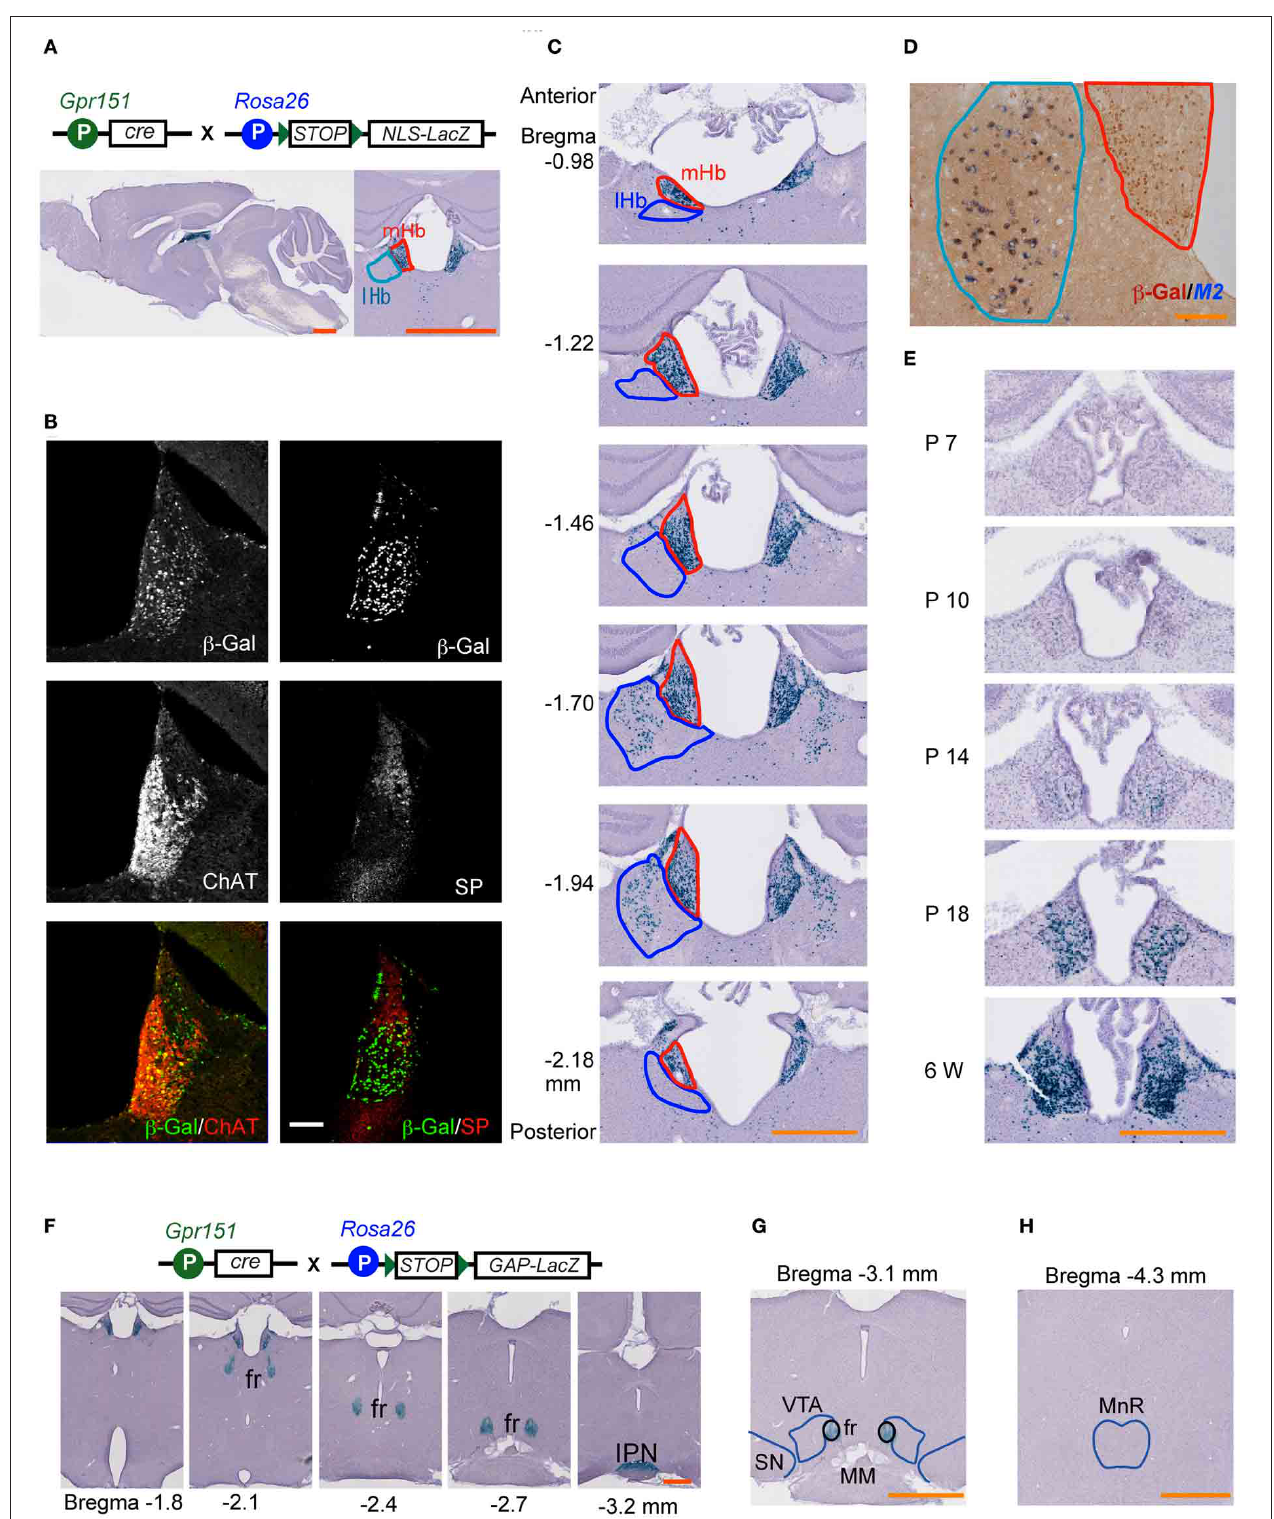
FIGURE 1 | Characterization of mHb-specific Cre expression transgenic mice. Transgene combinations are schematically illustrated at the top of the figure (A,F) . (A) β -galactosidase ( β -Gal) activity (blue signals) in Gpr151 -Cre:RNZ mouse brain sections. The left and right panels show sagittal